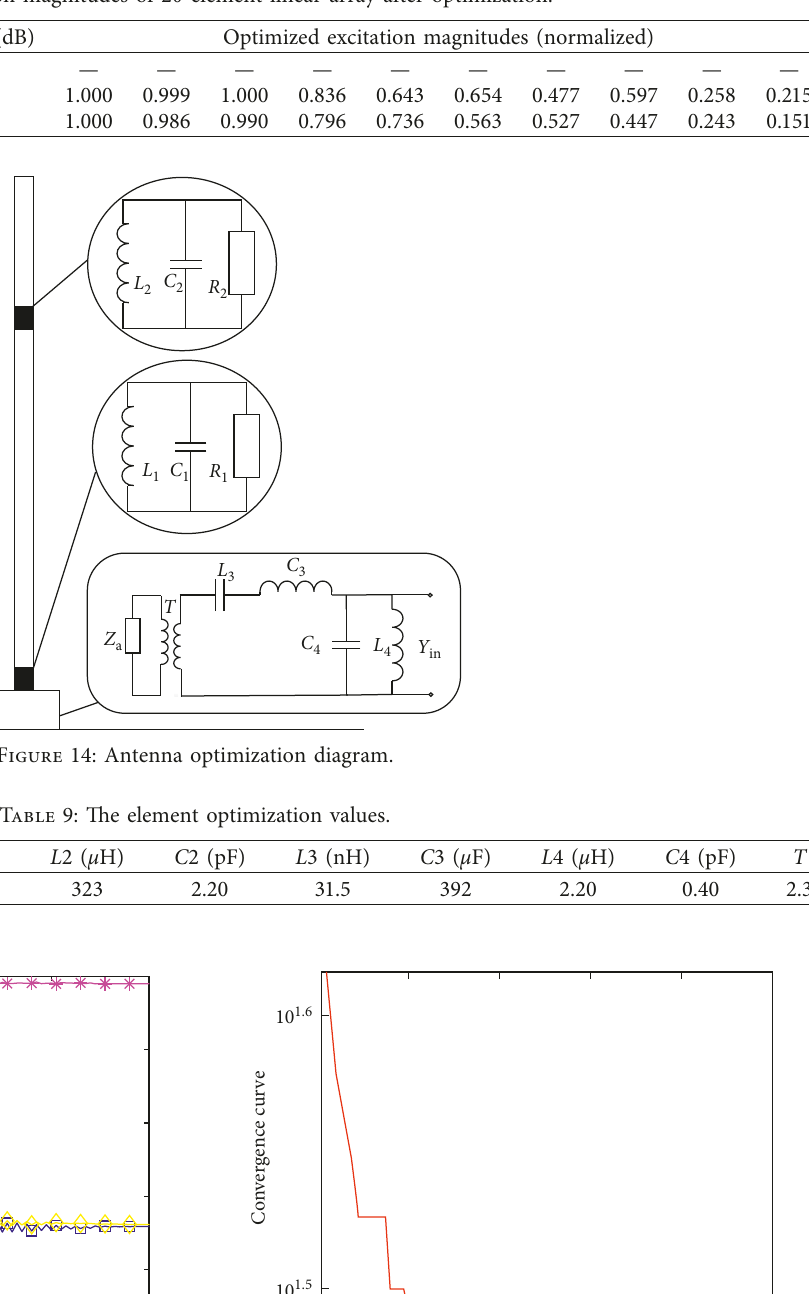
Table 8: Excitation magnitudes of 20-element linear array after optimization.